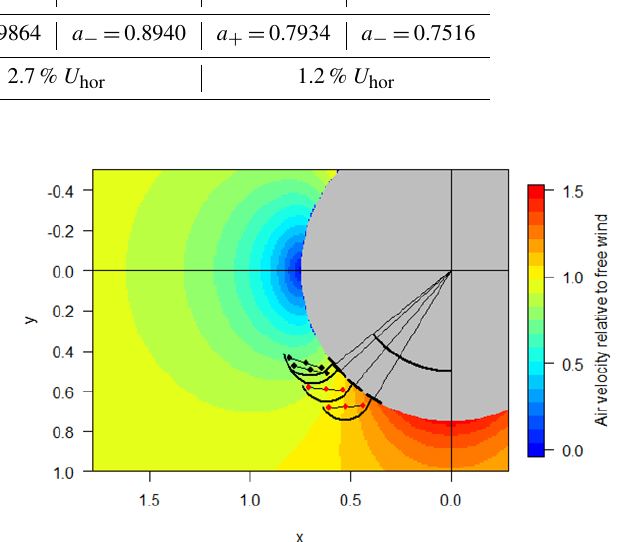
Figure 13. Simulation of the flow around the spinner, which was approximated to a sphere. The flow was calculated with the equa- tions of the potential flow around a sphere. The sensor positions re- trace the position of the sensors found in Fig. 12. The sensor paths with the red dots refer to the old mount (31, 40 ◦ ), while those with the black dots refer to the improved mounting (48, 51 ◦ ), where the sensors are more closely